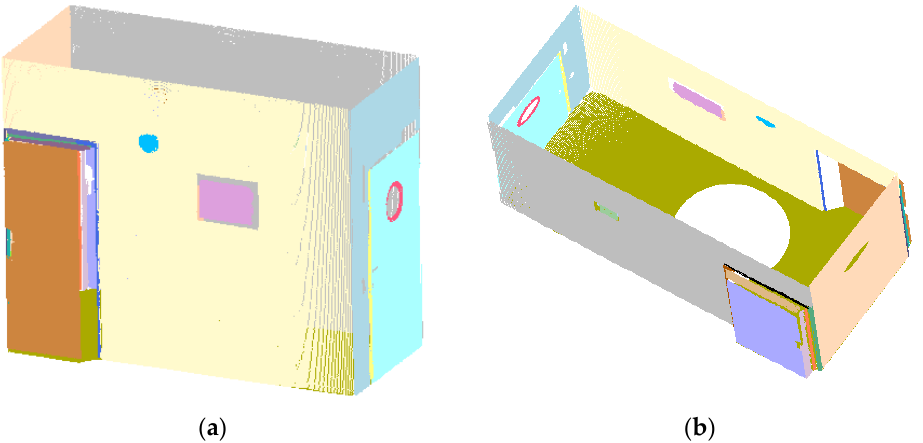
Figure 13. Cottage’s segmentation results using the RANSAC ‐ RG method: ( a ) front view and ( b ) top view.